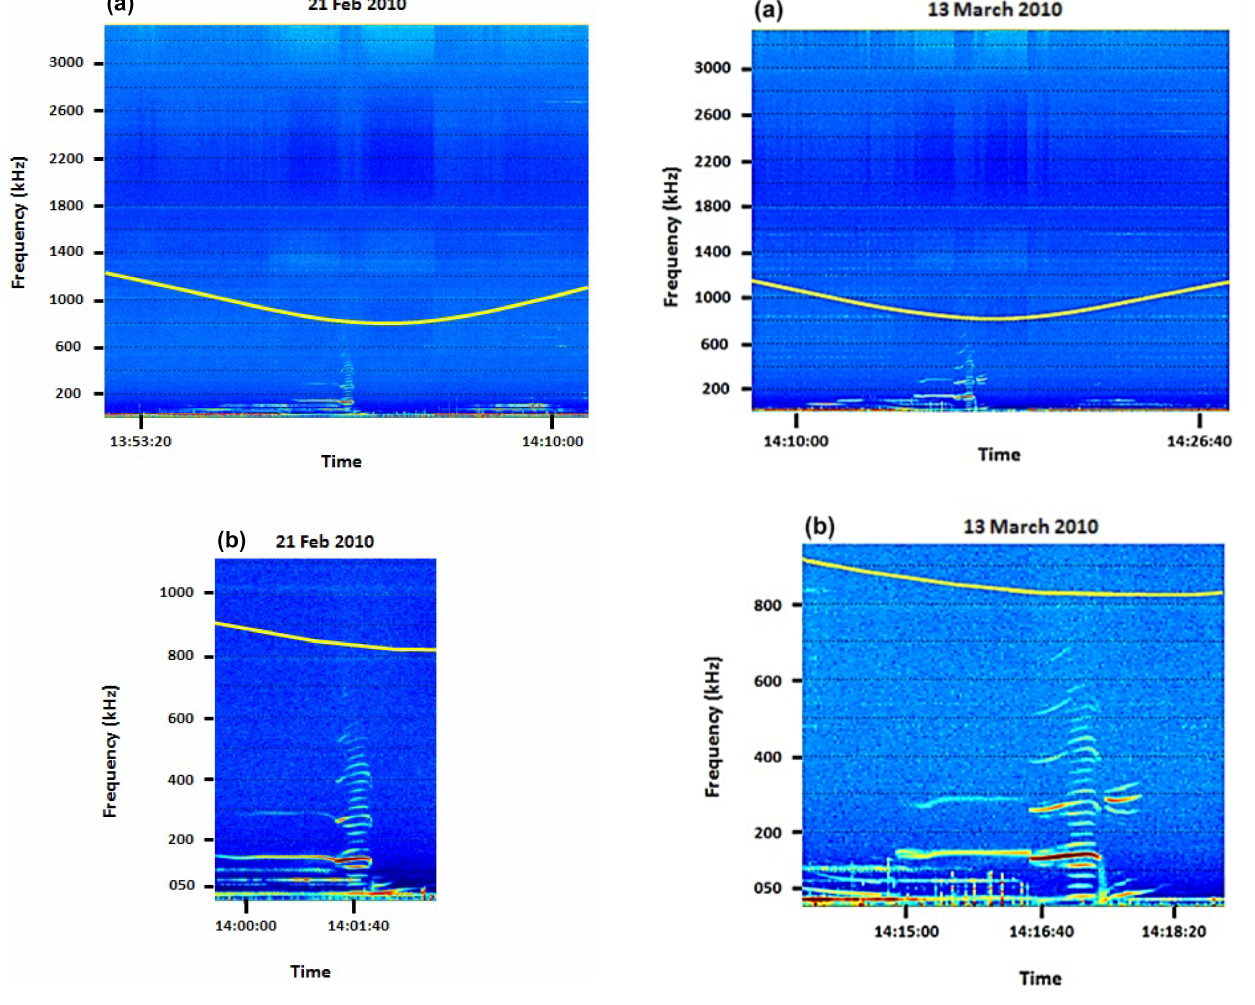
Figure 2. Like in Fig. 1 for an event recorded by DEMETER on 13 March